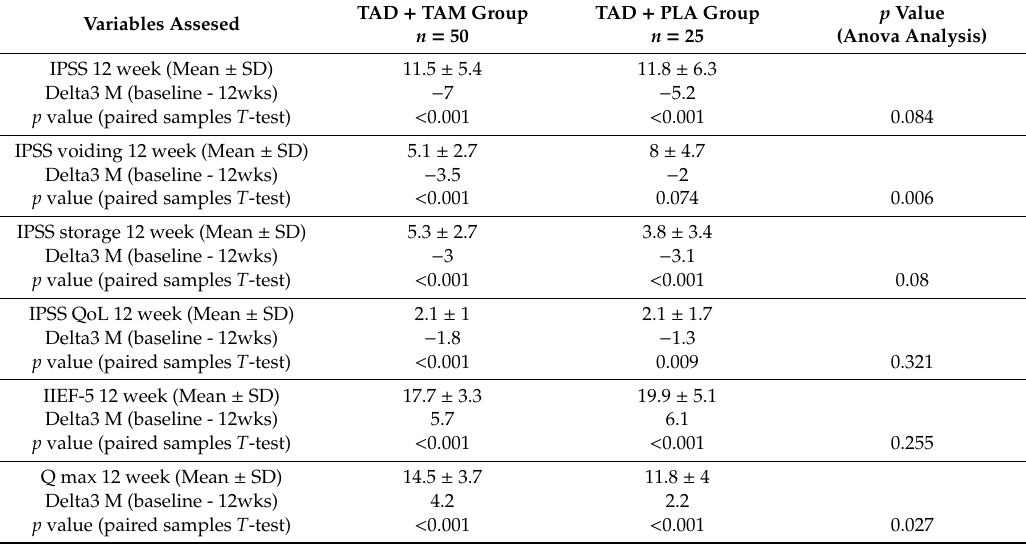
Table 2. Change from baseline to 12 weeks in tadalafil monotherapy (TAD + PLA-Group) and tadalafil plus tamsulosin (TAD + TAM-Group)